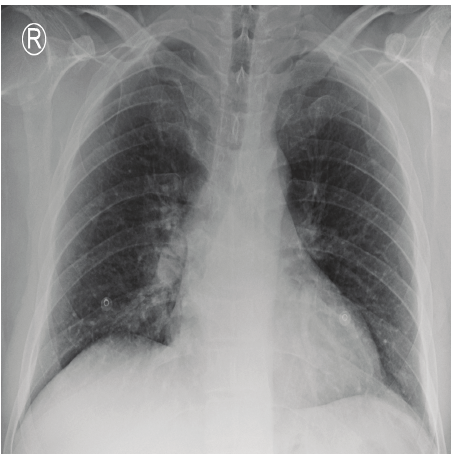
Figure 1. CXR of COVID-19 subject showing mild lung tissue